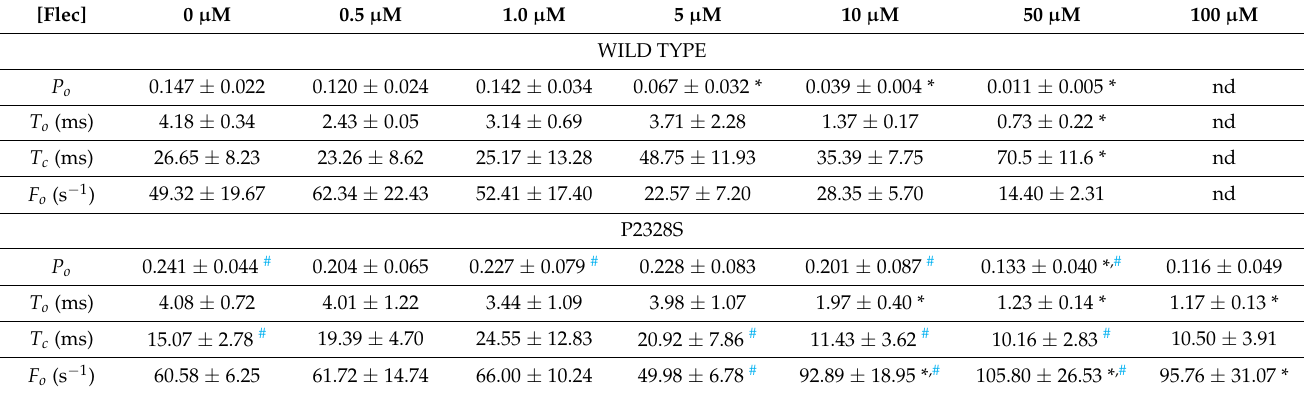
Table 1. Gating parameters for high or activity wild type (WT) and P2328S RyR2 channels before and during flecainide exposure. Parameter values for WT and P2328S channels before adding flecainide ([Flec] = 0 µ M) and with 0.5 µ M to 50 µ M (WT) or 100 µ M (P2328S) flecainide. 100 µ M flecainide not applied to WT channels (nd, not done). Mean ± SEM is presented. P o , open probability; T o , mean open time; T c , mean closed time; F o , frequency of opening. Asterisk (*)